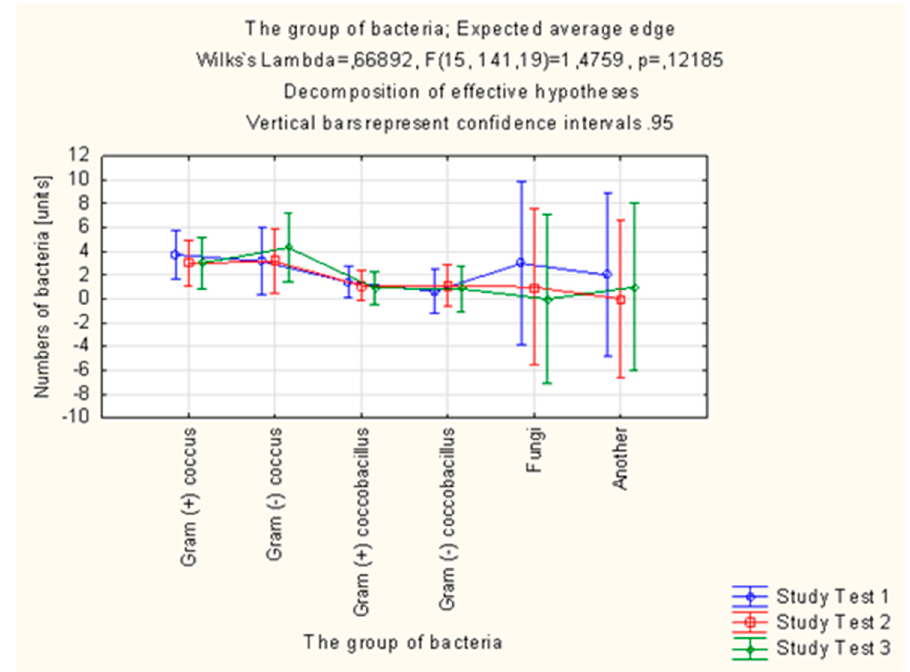
Figure 4. Distribution of isolated microorganisms in the study group. Molecules 2017 , 22 , 1957